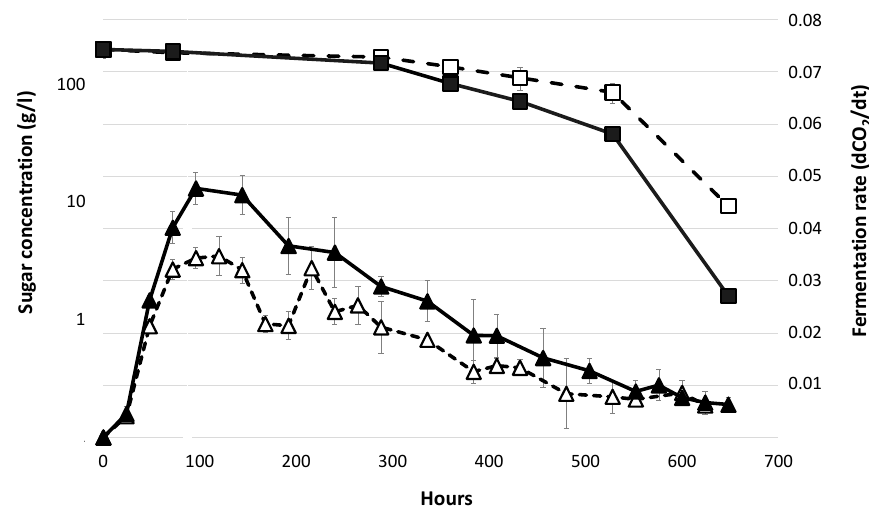
Figure 2. Fermentation kinetics and sugar consumption of M25 during growth in FSJ (straight lines) and SJ (dotted lines). Black triangles: fermentation rate in FSJ; white triangles: fermentation rate in SJ; black squares: residual glucose in FSJ; white squares: residual glucose in SJ. Data are means ± standard deviation of three independent biological replicates.